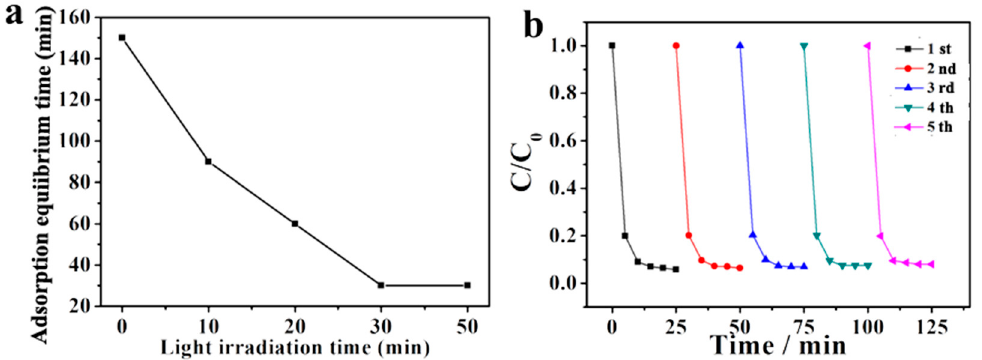
Figure 13. ( a ) Correlation between the time duration for reaching the equilibrium adsorption and the time duration of light-irradiating the CCT-BFO adsorbent after equilibrium adsorption of MB; ( b ) Changes in the relative concentrations of MB aqueous solutions, added by the CCT-BFO adsorbents undergoing a different number of cycles of adsorption-photocatalytic regeneration, versus time. The MB initial concentration is 10 mg·L − 1 , the pH value of the solution is 7.